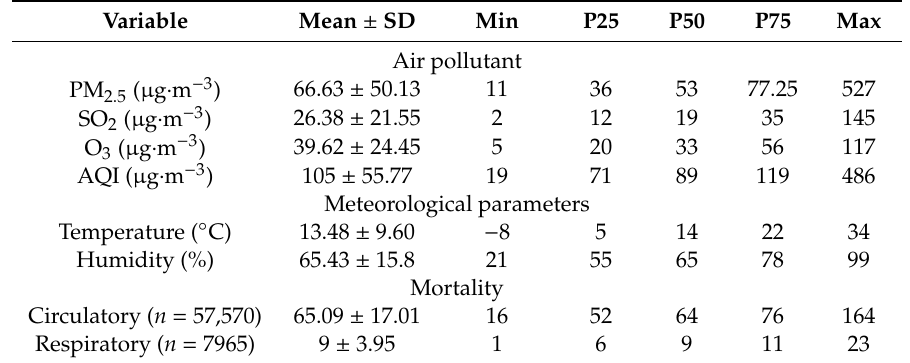
Table 1. Descriptive statistics of ambient air pollutant concentrations, climatological factors, and mortality (cardiovascular and respiratory) in Xi’an from 2014–2016.